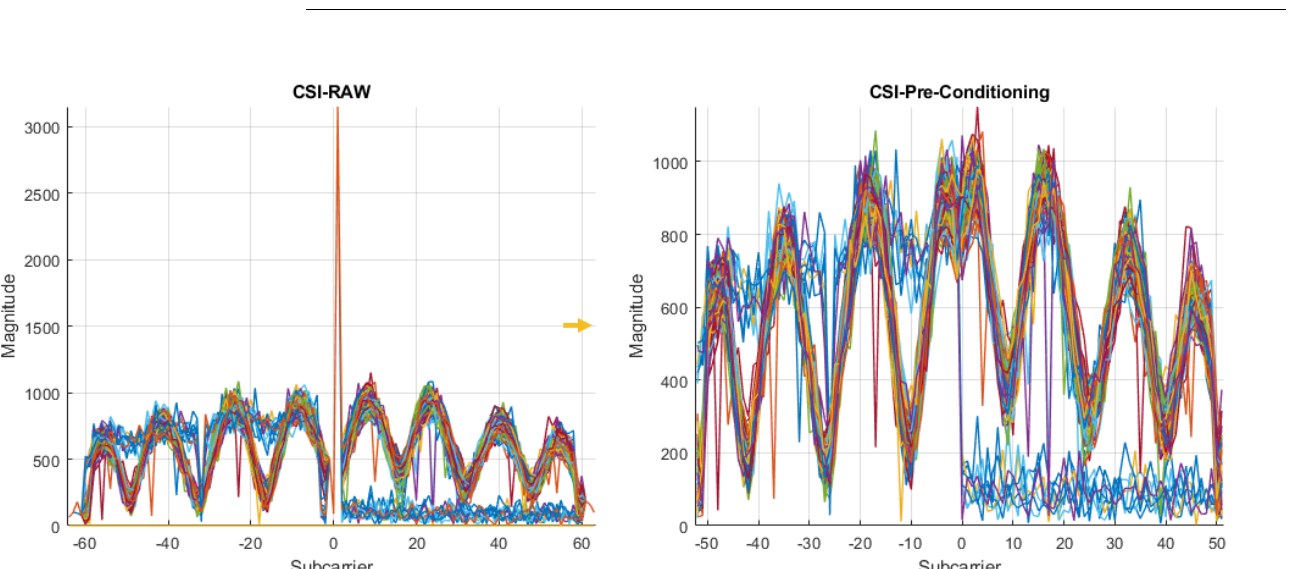
Algorithm 1 CSI-D ATA P REPROCESSING